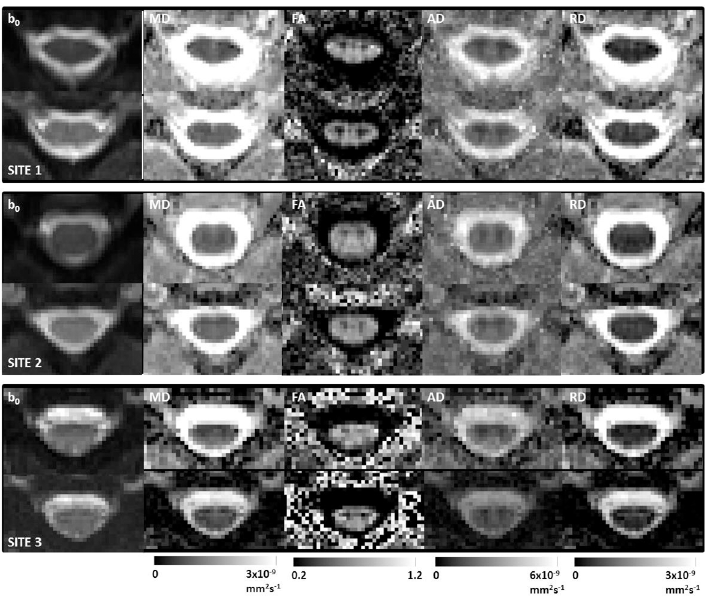
Fig 3. Single subject central slice parameter maps for both protocols acquired at sites 1, 2 and 3 (London, Vanderbilt and Montreal) respectively from top to bottom (for the same subjects as in Figs 1 and 2, but as before not the same subject at each fo the three sites). For each figure the images from left to right are: mean b 0 , MD, FA, AD and RD, with images acquired using the OVS protocol on top and the rFOV implementation at the bottom, and associated colour bars given underneath.